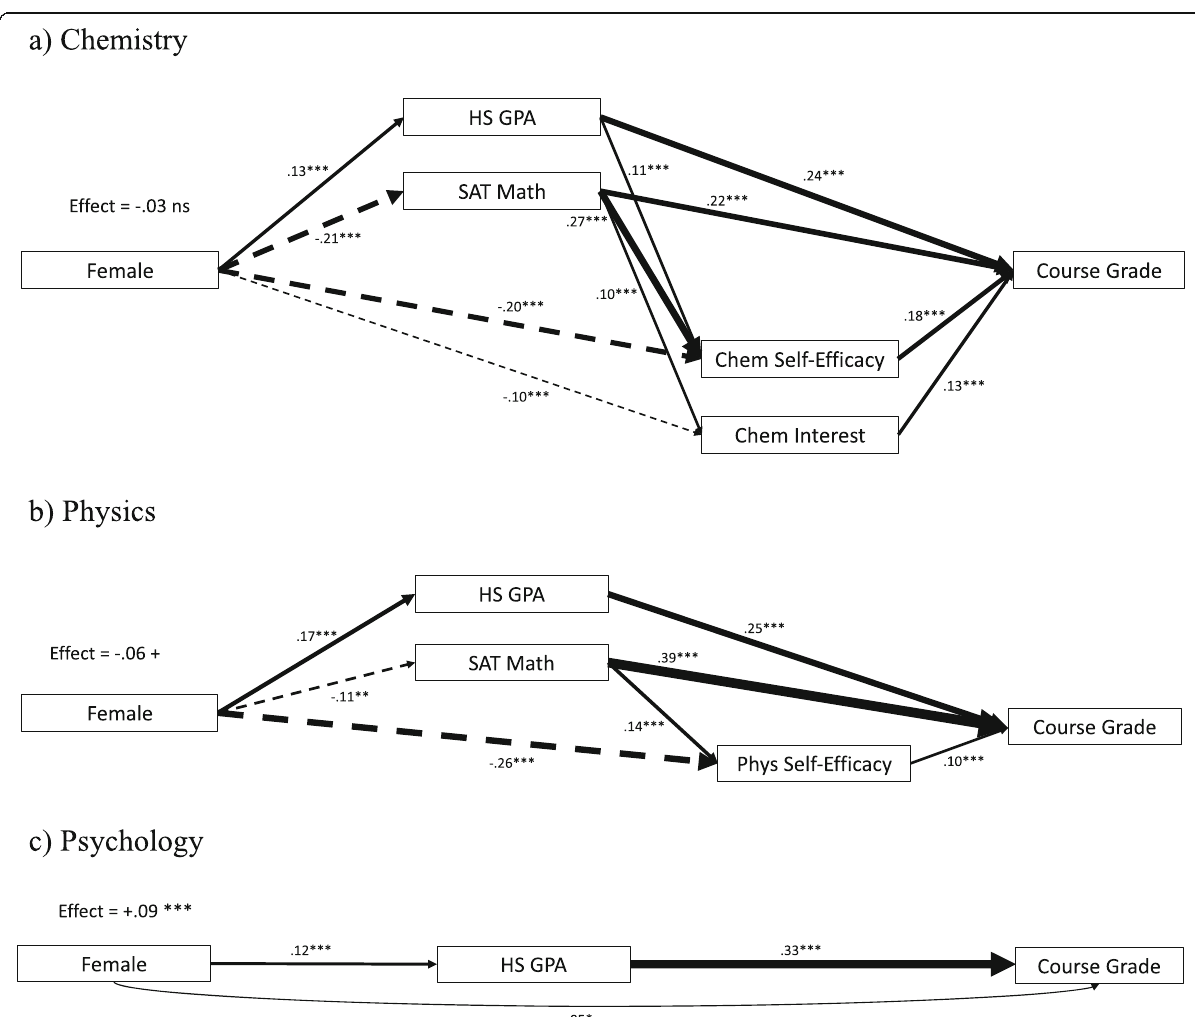
Fig. 2 Significant direct effects between students ’ gender, academic resources, discipline-specific attitudes, and introductory course grades. Note: Solid arrows indicate significant direct effects, dashed arrows indicate significant negative direct effects, and line thickness denotes the size of the standardized path coefficient. These figures only display pathways with significant indirect effects relevant to course grade outcomes; see Fig. 5 for all significant pathways. The final models for each course provided good fits to the data: chemistry RMSEA < .01 (90% CI .00, .03), CFI > .99, and TLI > .99; physics RMSEA = 0.01 (90% CI 0.00, 0.03), CFI > .99, and TLI > .99, and psychology RMSEA = 0.02 (90% CI 0.00, 0.03), CFI > .99,